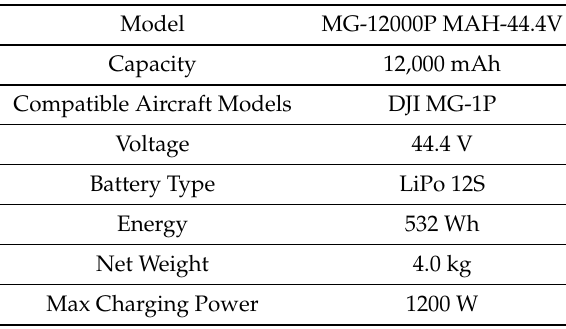
Table 5. UAV specifications.